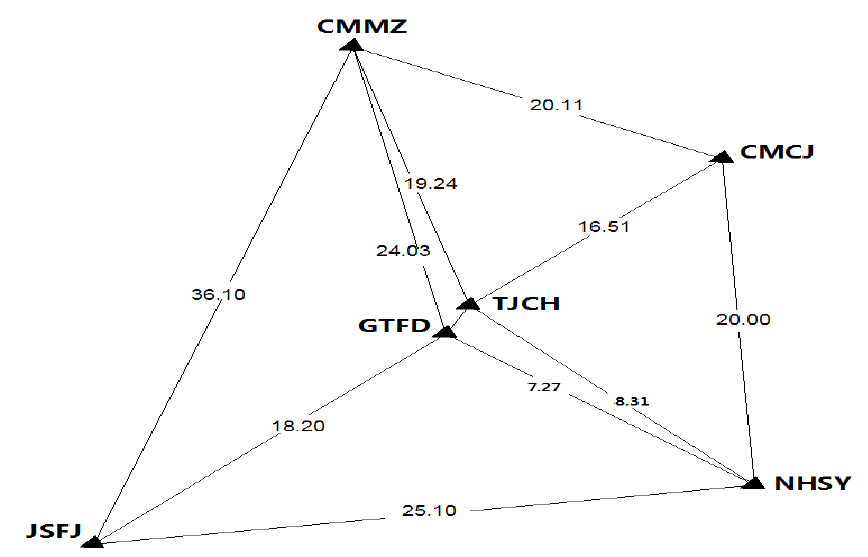
Figure 2. Stations distribution and inter-station distance (km).